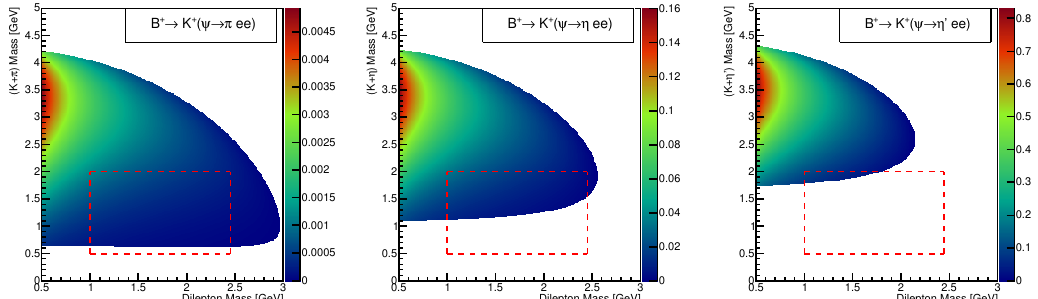
Figure 7 . The background from B + K + ( h‘ + ‘ (cid:0) ) with h = (cid:25); (cid:17); (cid:17) 0 on the (cid:22) B X ‘ + ‘ (cid:0) s ! ! ! phase space. The color bar corresponds to the branching ratio di(cid:11)erential in dilepton mass ( p s ) and hadronic mass ( M ), in units of 10 (cid:0) 8 GeV (cid:0) 2 . The outlined box indicates the 1 GeV 2 < q 2 < 6 GeV 2 X and M < M < 2 GeV cuts. A single-pole parameterization of the transition form factor [114] K X with the same (cid:3) = 3 : 686 GeV for (cid:25); (cid:17); (cid:17) 0 was used to generate the plots. The fact that the cuts are less e(cid:14)cient for (cid:25) is not problematic due to the small rate of this channel. ! Due to the V A coupling of the underlying transition b sc (cid:22) c , (cid:22) B X prefers the 1 (cid:0) ! ! longitudinal polarization [115, 116] with corrections quanti(cid:12)ed in NRQCD [117]; this fact reduces the background from the cascades because (cid:17) ( (cid:17) 0 ) and X cannot be collinear through 1 the dominant longitudinal polarization. The resulting distribution in the [ q 2 ; M ] plane for X the decays into (cid:17) and (cid:17) 0 are presented in (cid:12)gure 7, where we take for simplicity a constant value (cid:11) = 0 : 59 corresponding to the low M bin of the BaBar measurement: this causes X 1 (cid:0) the M cut to be more e(cid:14)cient by about X